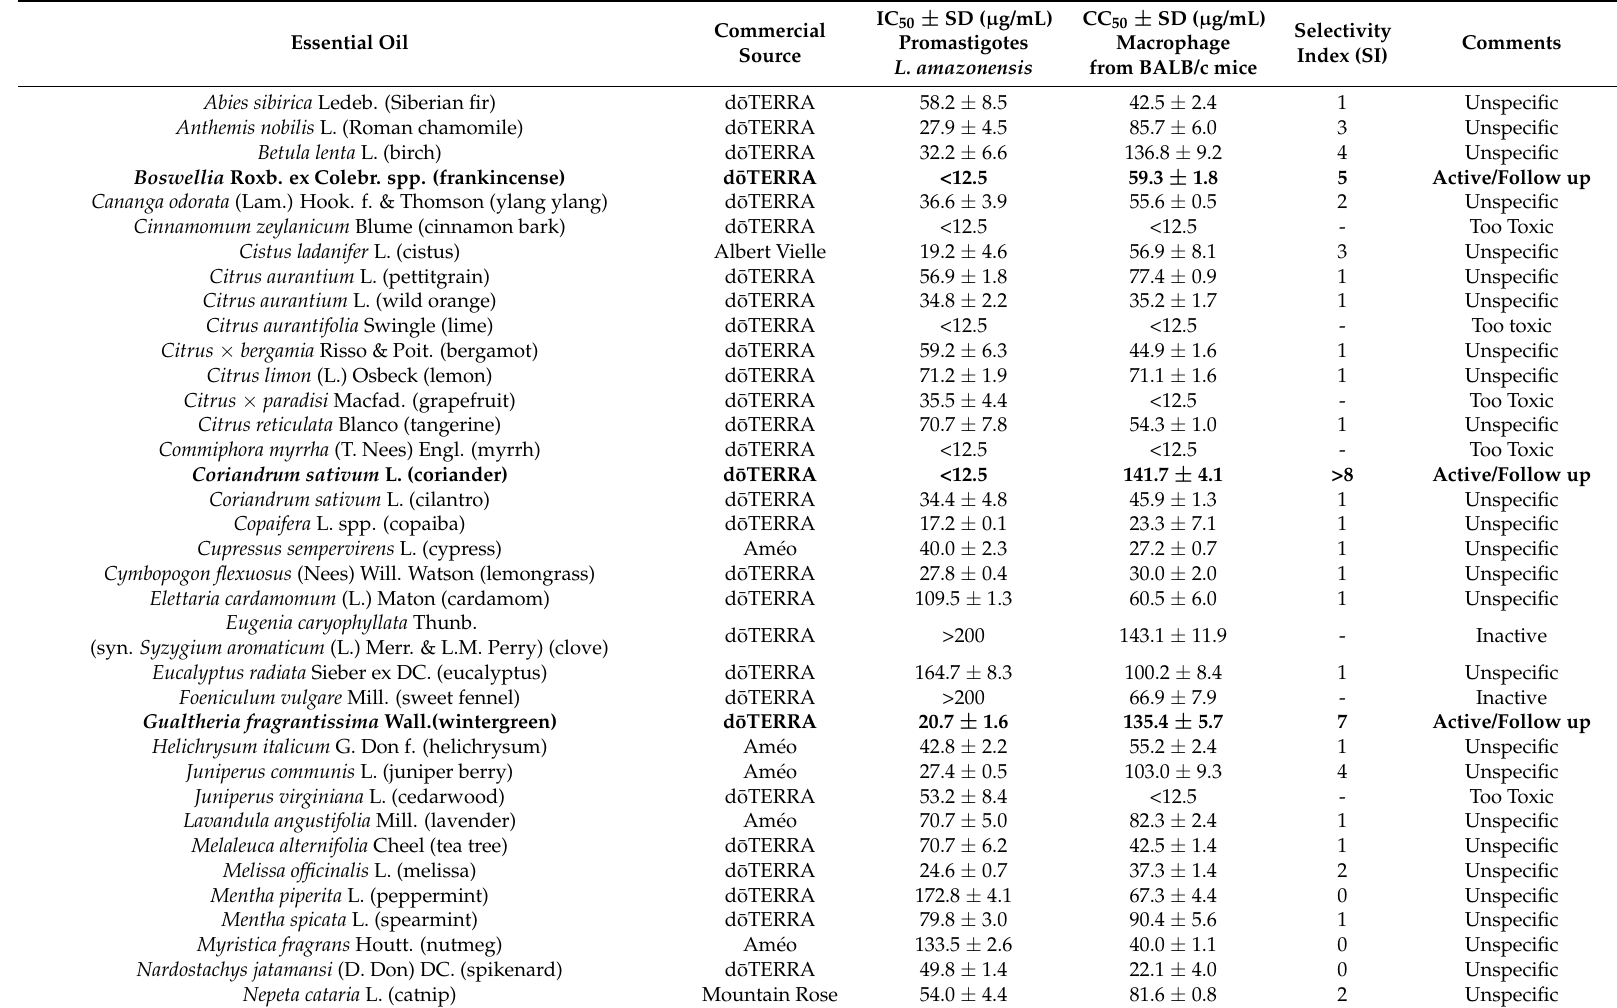
Table 1. Screening of 52 essential oils against Leishmania amazonensis promastigotes and BALB/c mouse peritoneal